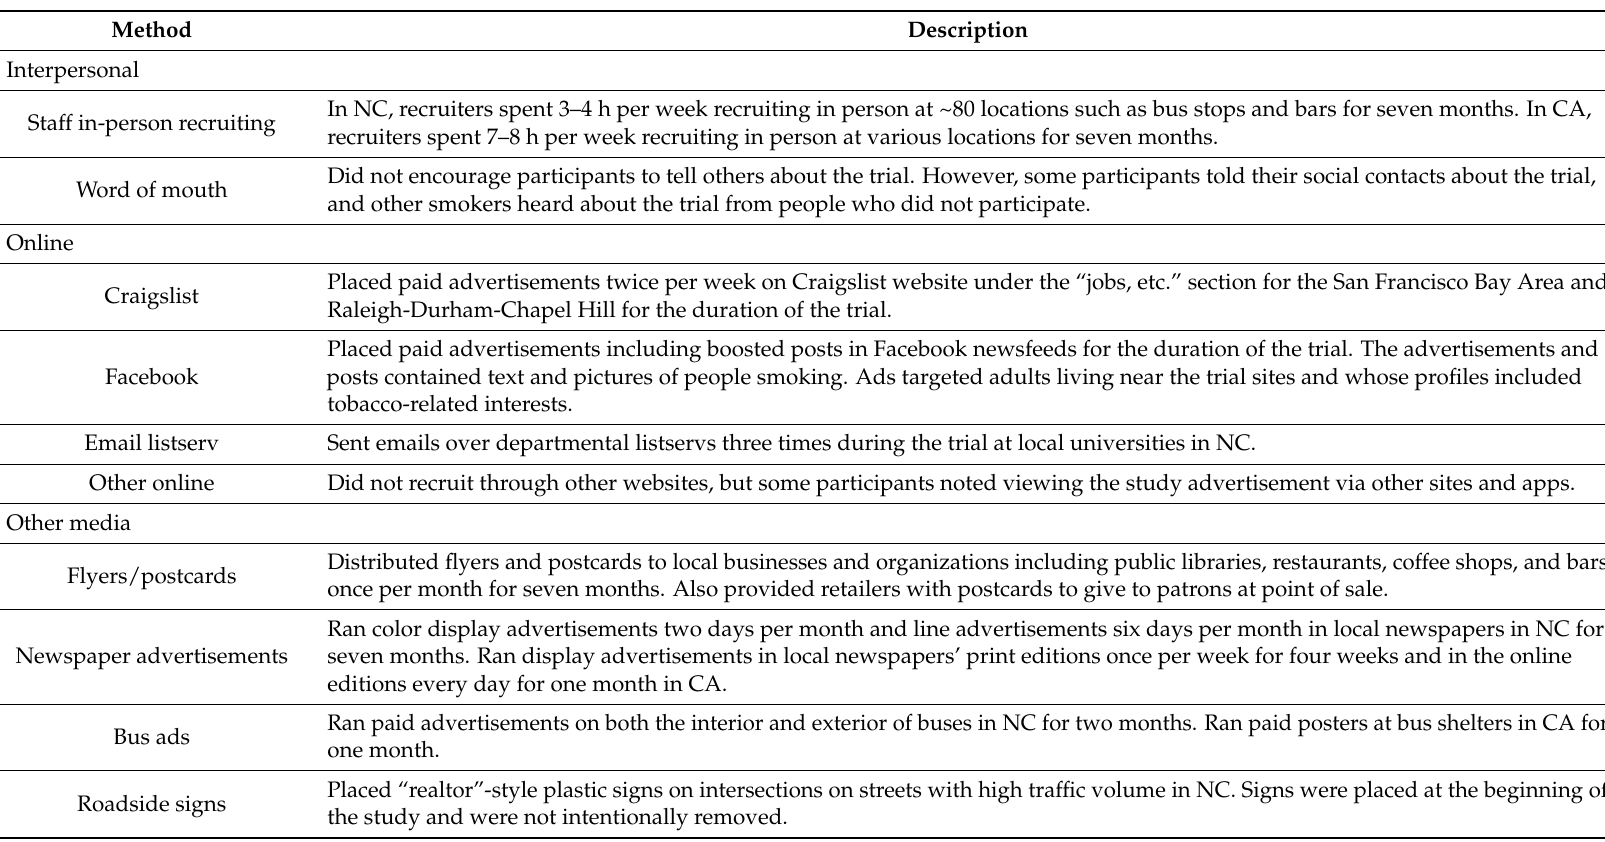
Table 1. Recruitment